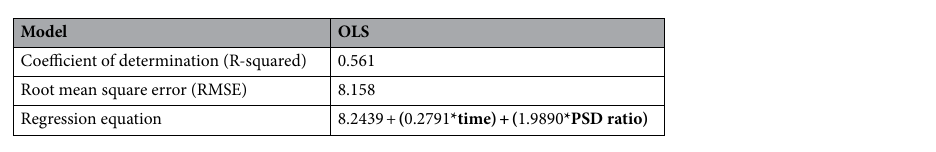
Table 3. Regression Analysis for the estimation of